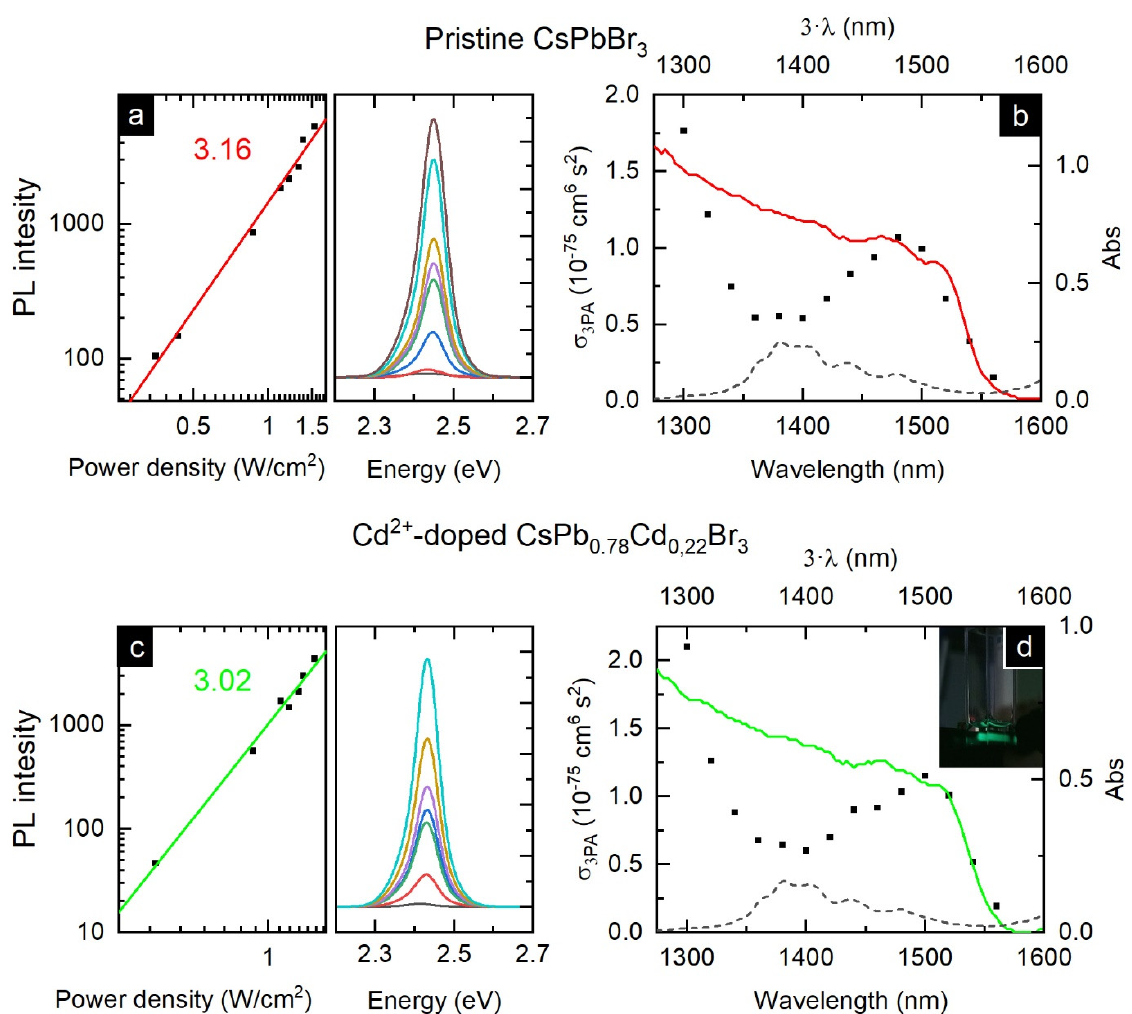
Figure 5. Three-photon excited photoluminescence of the studied NC. The log–log plots of the integrated PL area vs. power density for CsPbBr 3 NCs ( a ) and CsPb 0.78 Cd 0.22 Br 3 NCs ( c ). On the side are corresponding 3PA-excited PL spectra measured at different excitation power densities. 3PA absorption cross-section spectral dependencies for ( b ) CsPbBr 3 NCs and ( d ) CsPb 0.78 Cd 0.22 Br 3 NCs (on the inset is the photo of the PL from the CsPb 0.78 Cd 0.22 Br 3 NC solution when excited at 1560 nm). Dashed lines in ( b , d ) are the absorption of toluene at 1300–1600 nm, while colored lines show corresponding linear absorption drawn as a function of Abs(3· λ ).